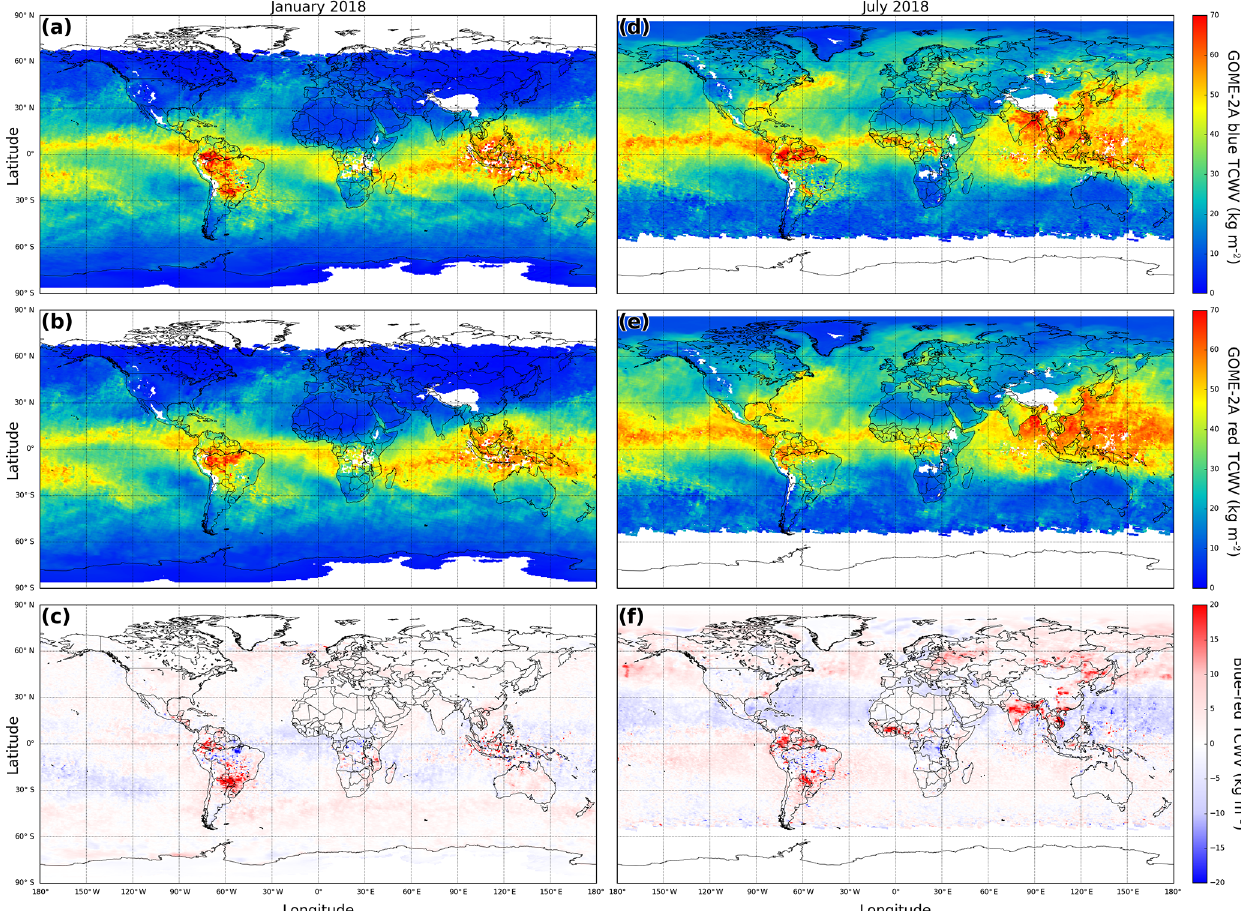
Figure 7. Monthly average TCWV derived from the GOME-2A observations. Panels (a) and (d) show data from the blue band retrieval, panels (b) and (e) show data from the GOME-2 operational product (red band), and panels (c) and (f) show the differences between the two data sets. Panels (a–c) show the data from January 2018, while panels (d–f) show the data from July